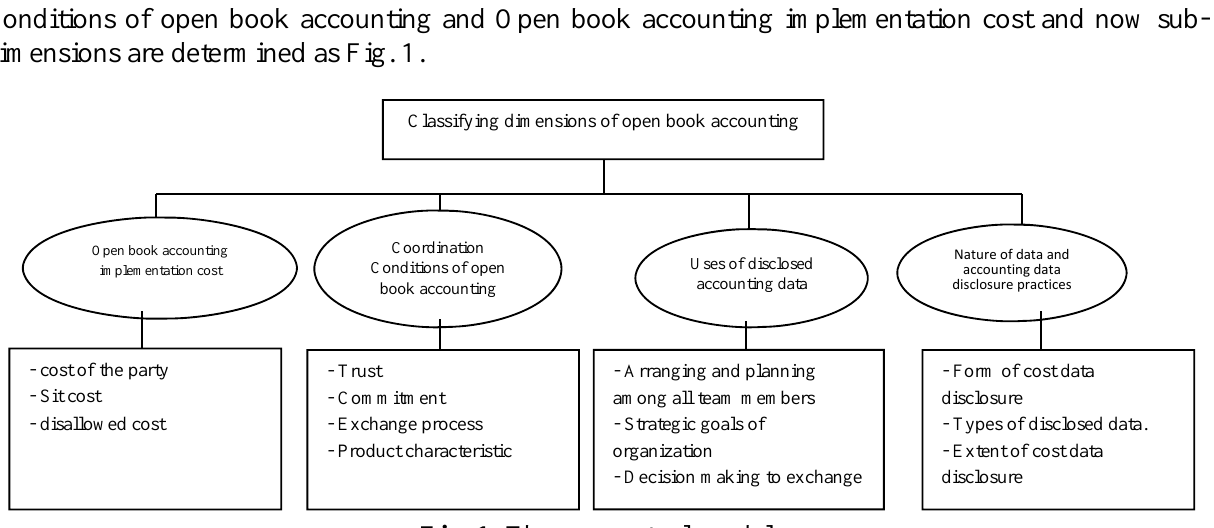
Fig. 1. The conceptual